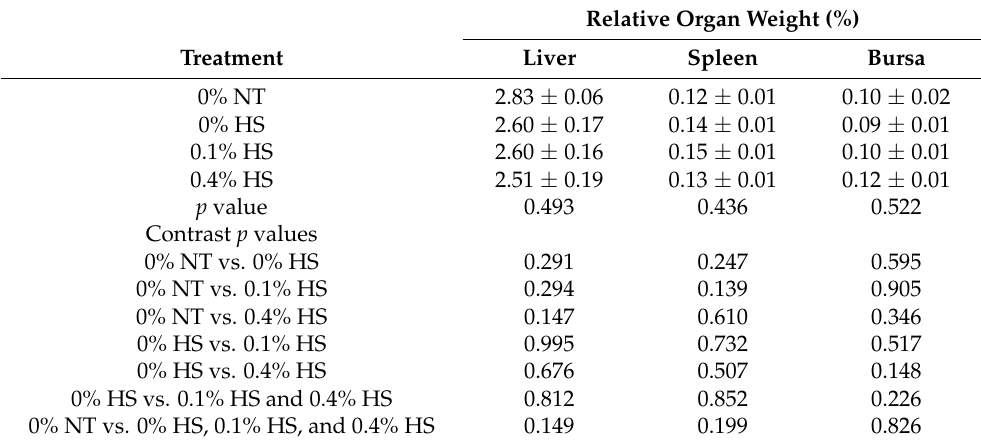
Table 3. Effects of supplementing diets with solubles from shredded, steam-exploded pine parti- cles (SSPPs) on the relative organ weight (% body weight) in broiler chickens exposed to either thermoneutral or heat-stress conditions.